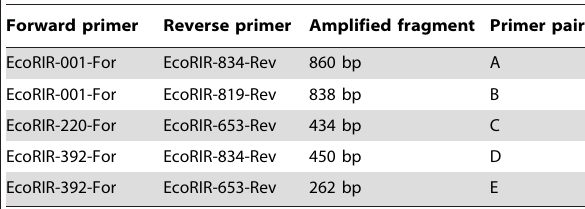
Table 2. Primer combinations for amplification of EcoRI gene sequence